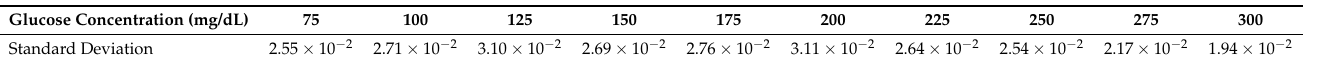
Figure 9. Relationships between the acoustic signals to the corresponding glucose samples for the three-day measurements. Table 6. Standard deviation of the three-day measurements using different skin